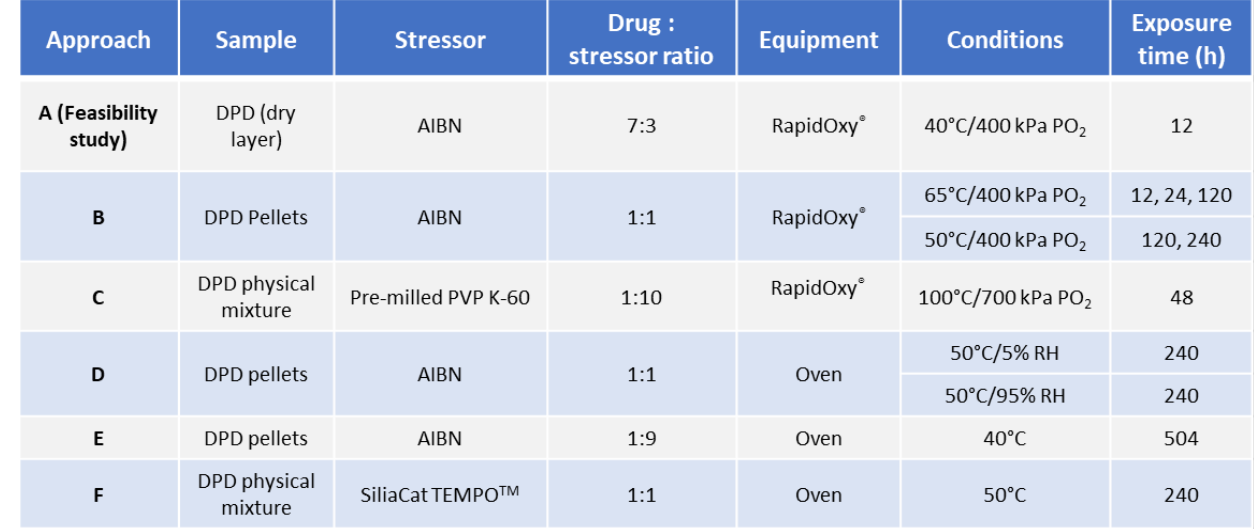
Figure 1. General workflow to test autoxidation in solid drugs.